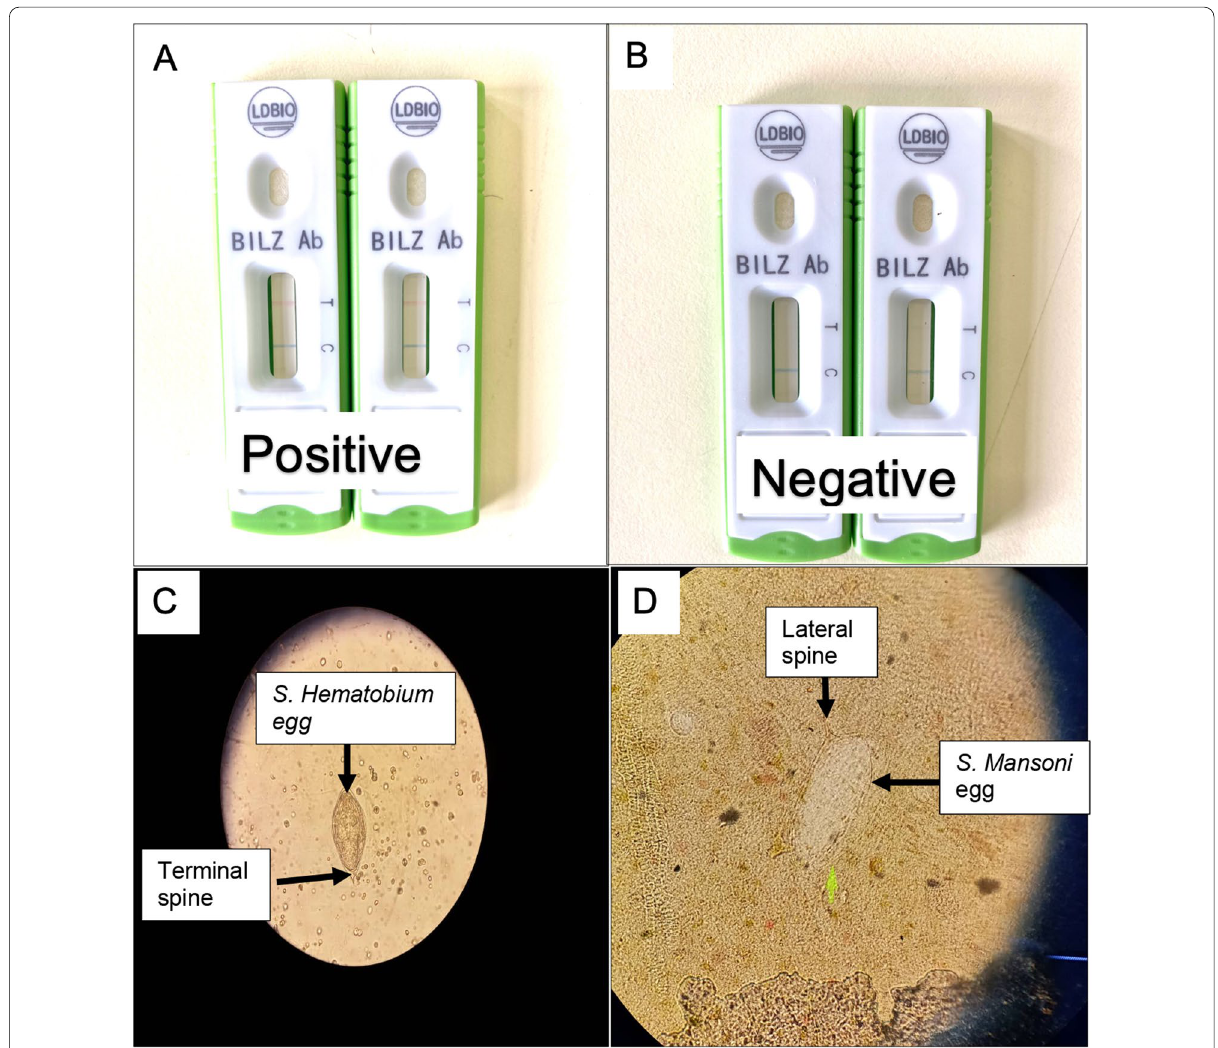
Fig. 2 Positive and negative results on the Schistosoma ICT IgG/IgM test ( A , B ). The negative test shows the presence of only one band—the control, whereas the positive test shows the presence of a second band. This band shows that there has been a reaction between antibodies in the sample and Schistosoma ICT IgG/IgM. Images C and D show Schistosome eggs in urine and in stool, respectively